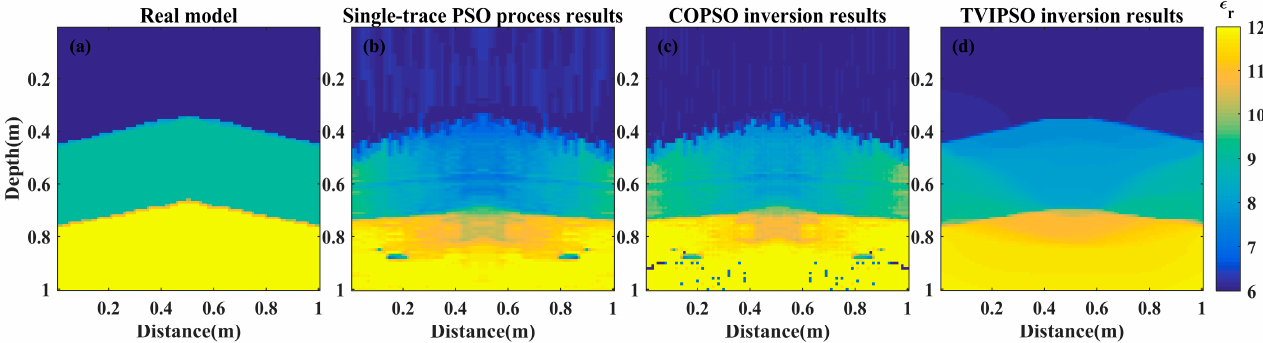
Figure 9. Model results: ( a ) real model; ( b ) initial model constructed using the single-trace PSO process; ( c ) COPSO inversion model; ( d ) TVIPSO inversion model.